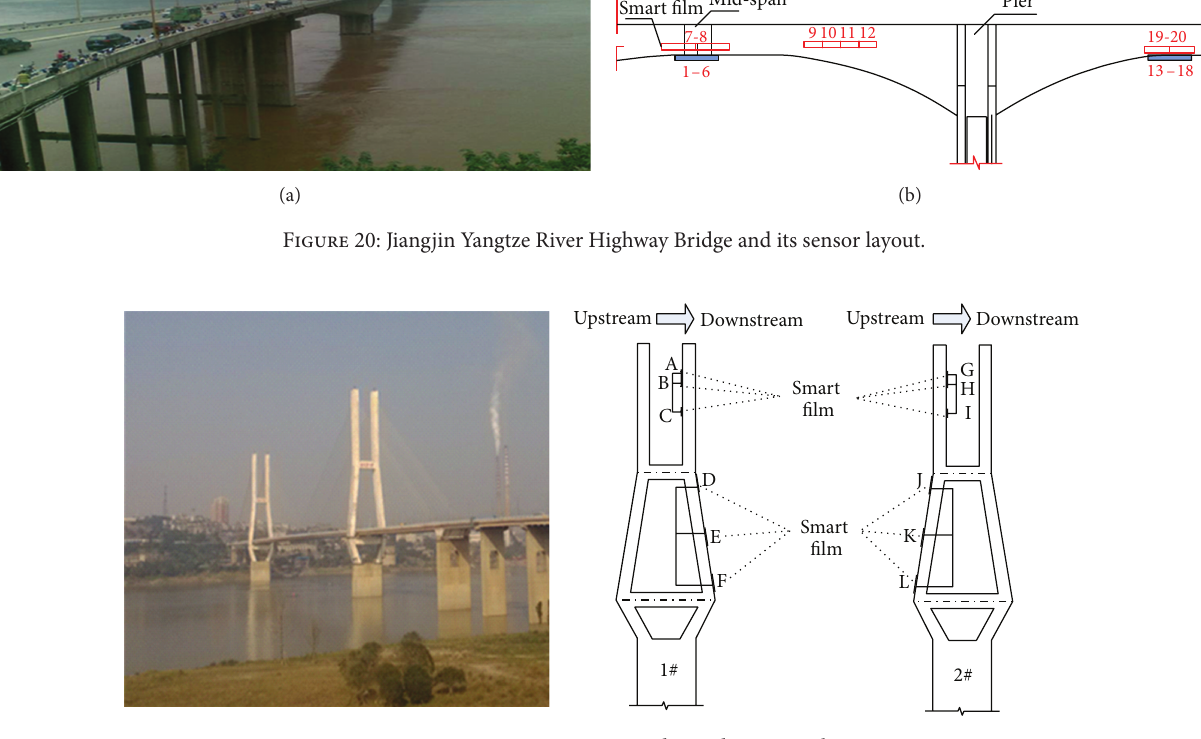
Figure 21: Lijiatuo Yangtze River Bridge and its sensor